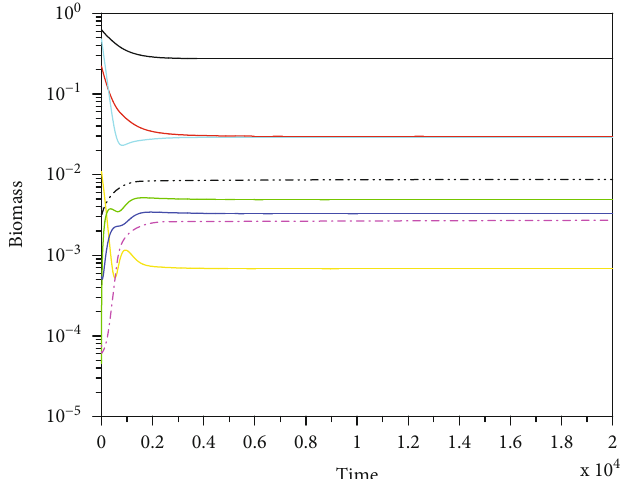
Figure 3: Dynamics of African cat fi sh, Nile tilapia, and two di ff erent food resources. The y – axis shows the biomass in grams per litre (in a logarithmic scale) for each fi sh compartment together with the food resources. The initial values are chosen positive; all harvest rates are set to 0.005 per day; other parameter values can be found in Tables 3 – 5.